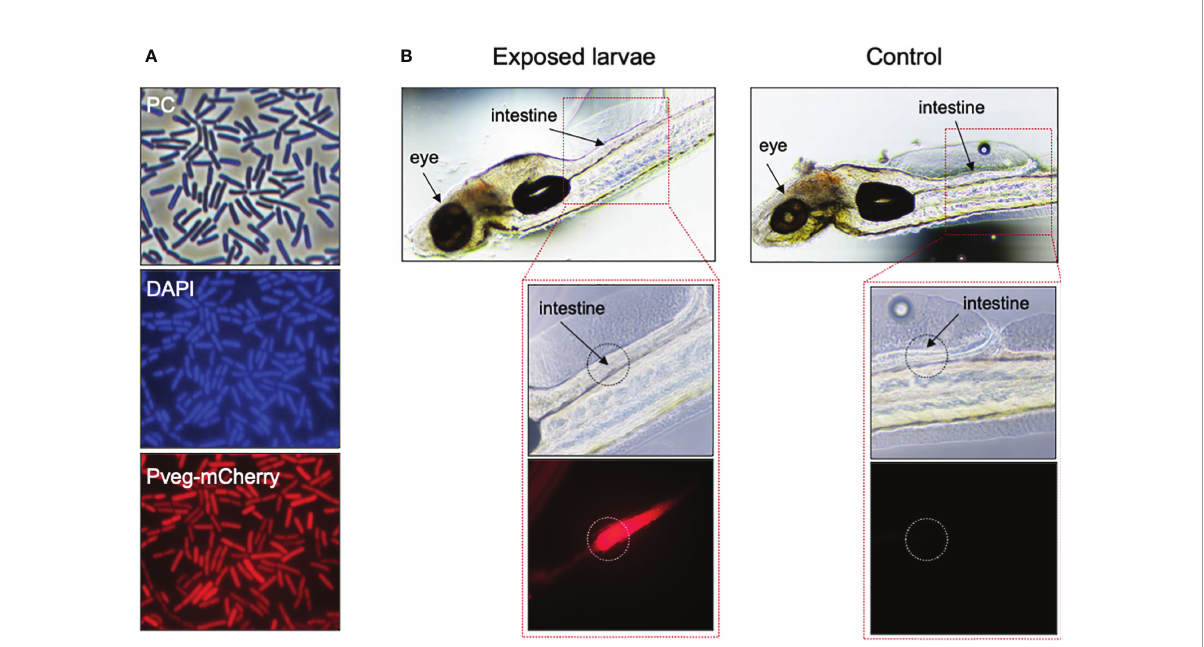
FIGURE 3 Fate of B subtilis cells after exposure by immersion to zebra fi sh larvae. (A) Phase contrast (PC, top panel) and fl uorescence microscopy of cells of B subtilis derivative CRS239, bearing a P veg-mCherry transcriptional fusion (bottom panel), grown for 4h in DSM at 37°C and 150 rpm. Cells were labeled with DAPI, for nucleoid staining (middle panel). (B) Same cells of CRS239 depicted in (A) , after 24h exposure by immersion to 6dpf zebra fi sh larvae, previously treated with 75 µM PTU. Larvae exposed to CRS239 cells (Exposed) show red fl uorescence at the intestinal level, while larvae that were not exposed (Control) do not.